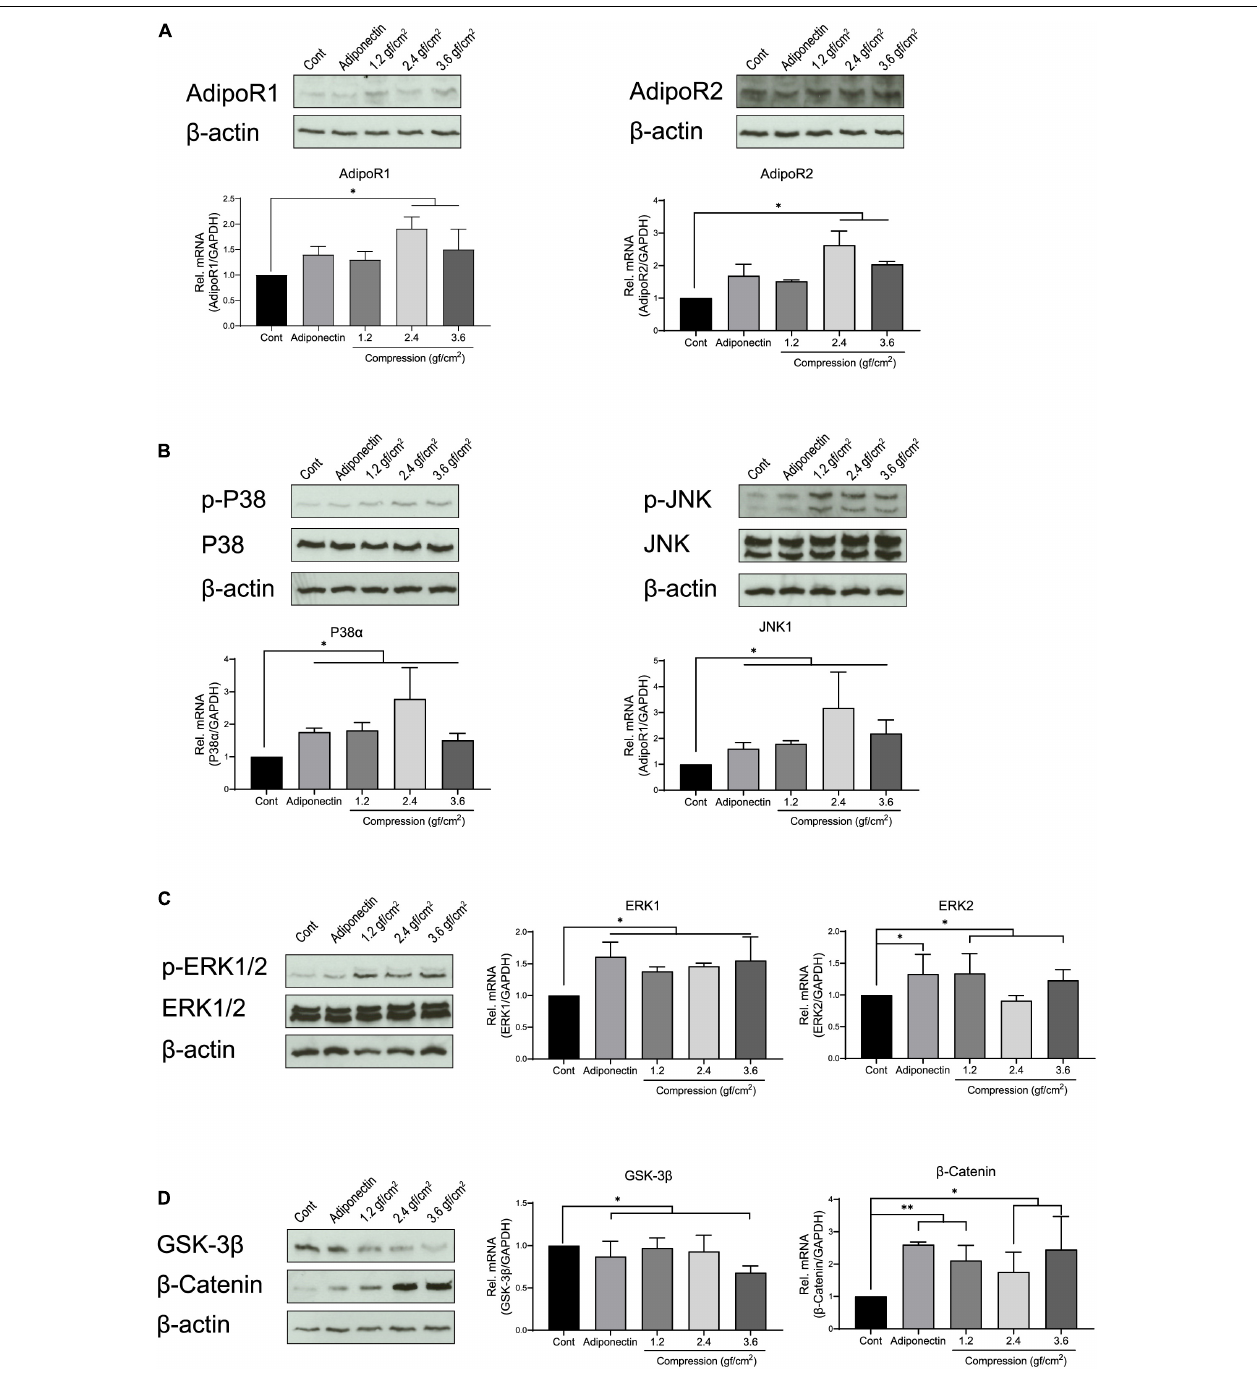
FIGURE 1 | Adiponectin as well as compression regulates the expression of adiponectin receptors (AdipoRs), mitogen-activated protein kinase (MAPK), and β -catenin. (A) Representative western blots showing the expression changes of AdipoR1 and AdipoR2 in the presence of adiponectin (100 ng/ml) or compression (1.2, 2.4, and 3.6 gf/cm 2 ). Real-time reverse transcriptase–polymerase chain reaction (RT-PCR) analysis shows that 2.4 or 3.6 gf/cm 2 compressive forces significantly increase mRNA expression of adiponectin receptors ( AdipoR1 and AdipoR2 ) in mouse OCCM-30 cells ( ∗∗ p < 0.01). (B,C) Western blots showing the expression of p-P38, p-ERK1/2, and p-JNK induced by adiponectin or compression. (D) The OCCM-30 cells show down-regulated mRNA expression of GSK-3 β when exposed to adiponectin (100 ng/ml) or compression (3.6 gf/cm 2 ), whereas up-regulated mRNA expression of β -catenin ( ∗∗ p < 0.01). β -Catenin protein expression was increased after compression stimulation ( ∗ p < 0.05). Graphics show mRNA expression levels of P38 α , JNK1 , ERK1, ERK2, GSK-3 β , and β -catenin after 60-min stimulation with adiponectin or compression. Data were derived from three independent experiments. Data is normalized to 1, and values are expressed as means ± SD. Asterisks indicate significant differences compared to control cells ( ∗∗∗ p < 0.001, ∗∗ p < 0.01, and ∗ p < 0.05; ns, not significant).